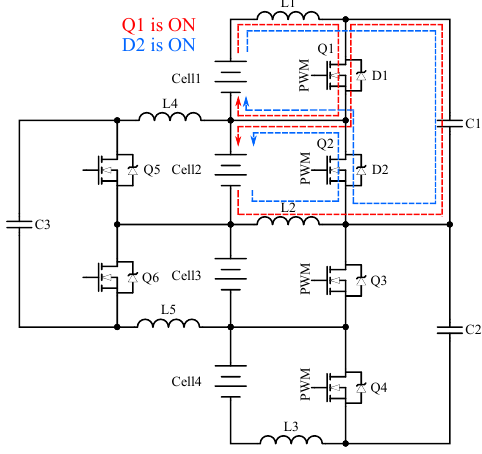
Figure 4. Conventional ´cuk converter balancing